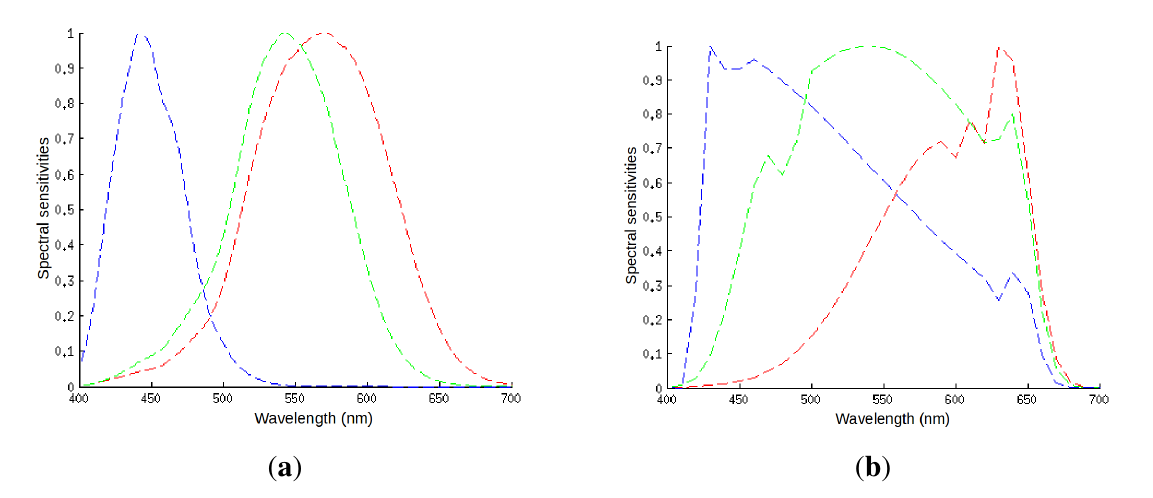
Figure 1. Spectral sensitivities of: ( a ) the three types of cones in a human eye; and ( b ) a typical digital